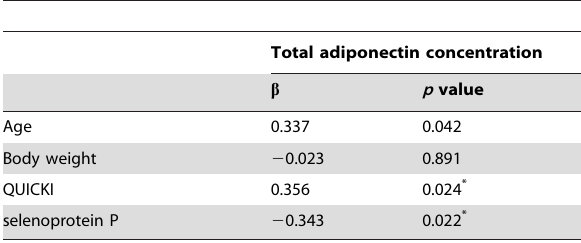
Table 6. Multivariate regression analysis of total adiponectin concentration as a dependent variable.